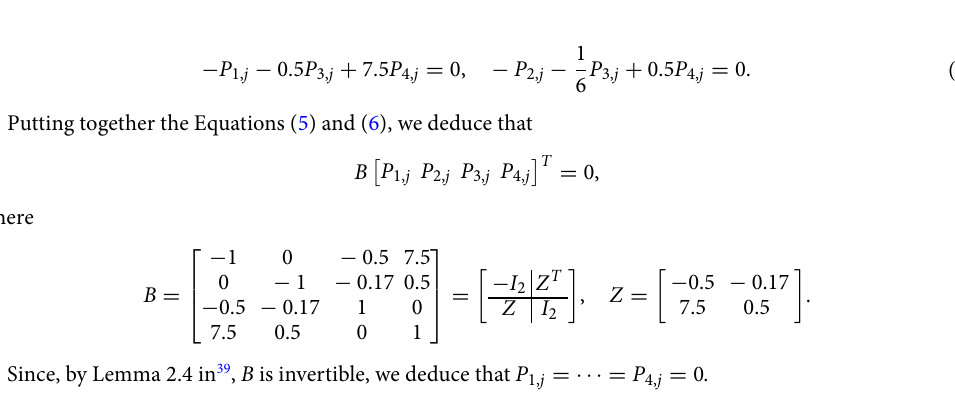
Figure 1. The graph associated to matrix A demonstrating the two